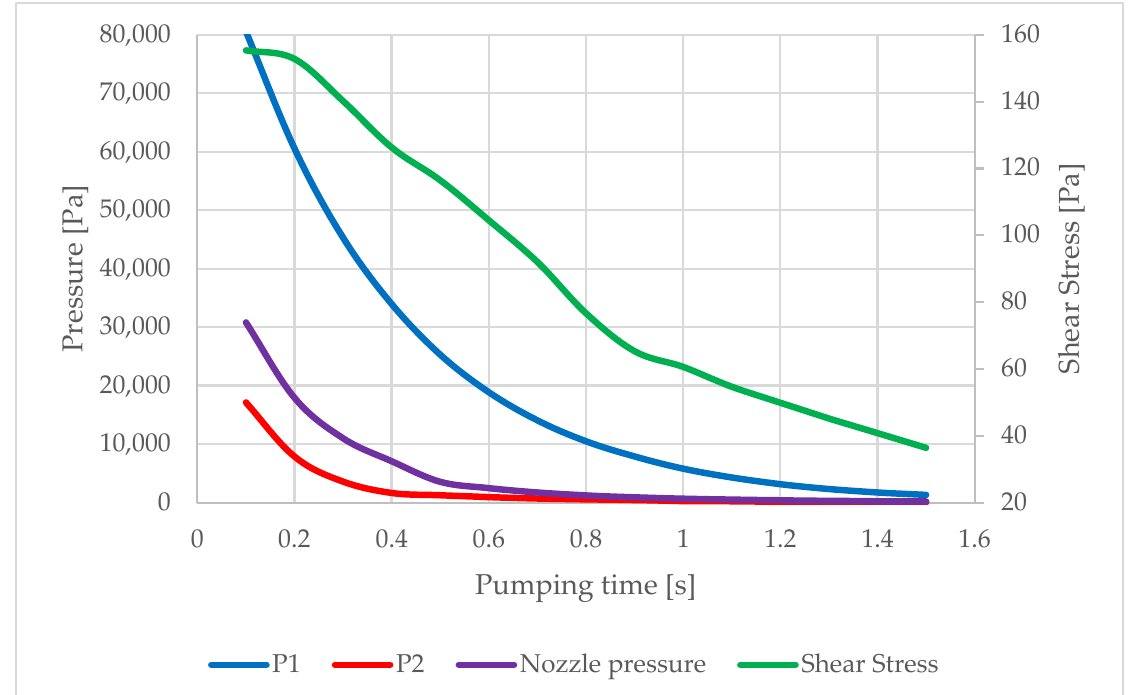
Figure 11. Evolution of monitored variables during chamber pumping.